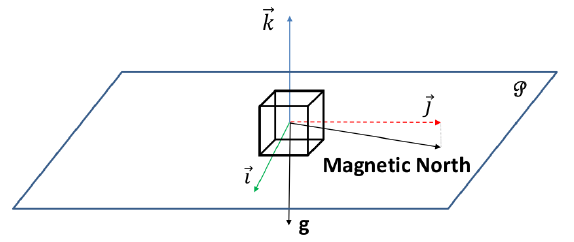
Figure 3. Representation of the reference basis in the satellite frame of